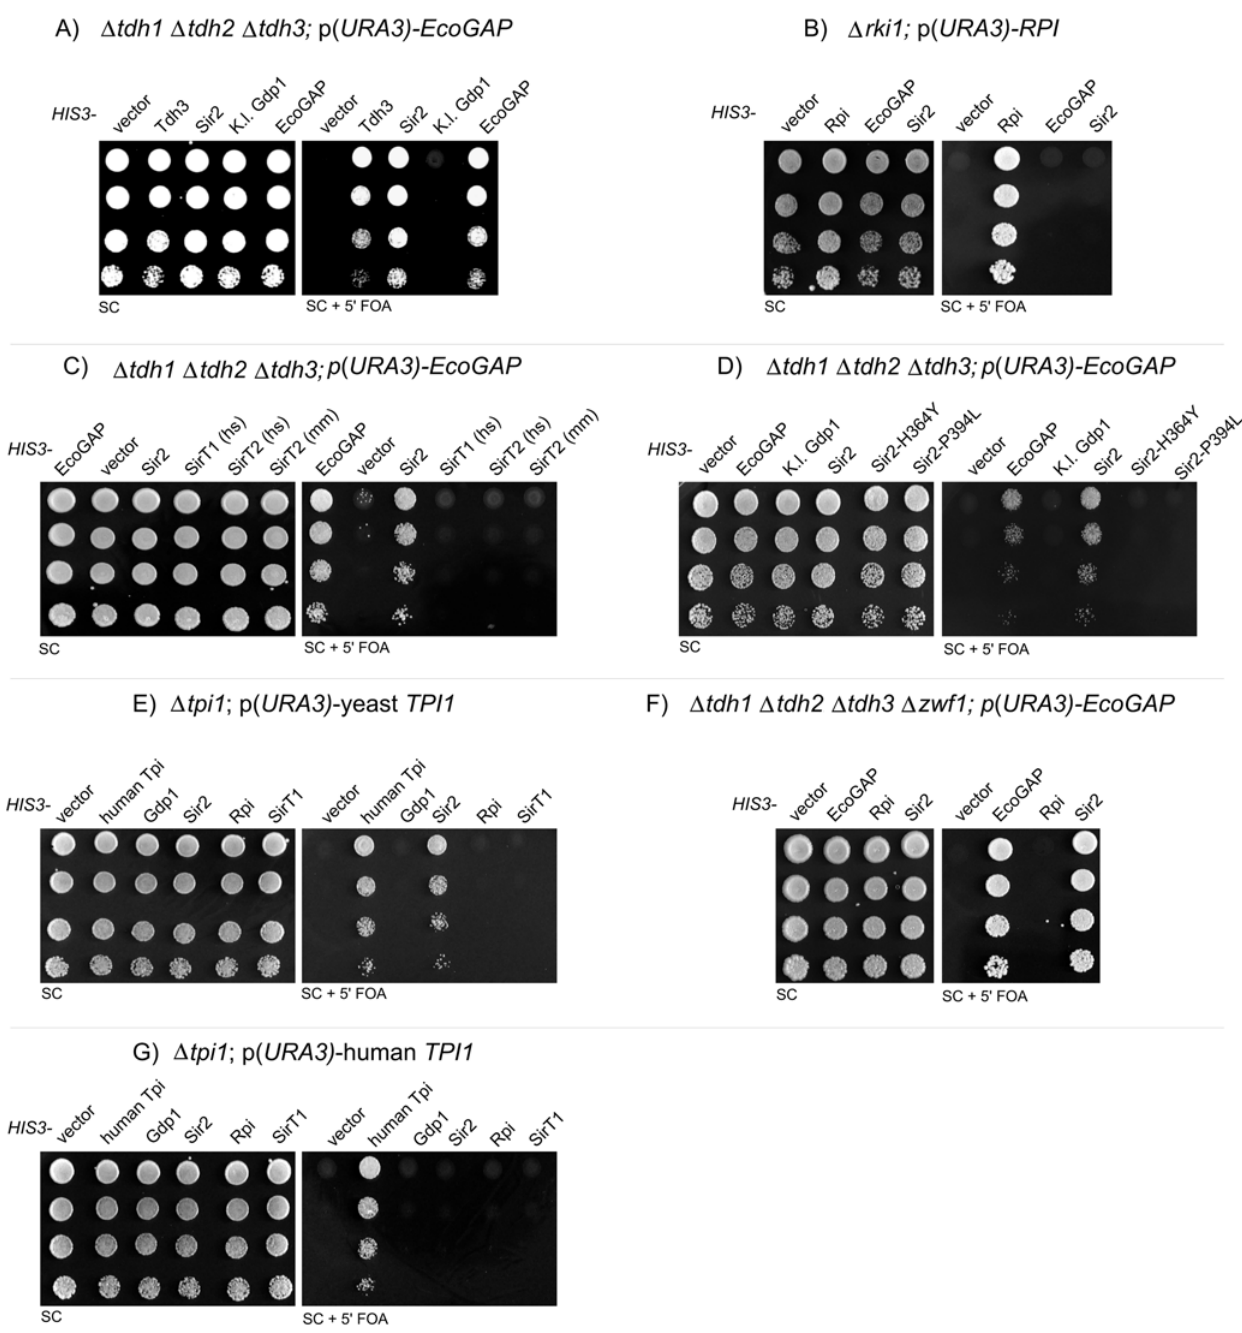
Figure 1. D tdh1 D tdh2 D tdh3 yeast survives counter-selection of a GAPDH-encoding plasmid when Sir2 is overexpressed. (A) The D tdh1 D tdh2 D tdh3 strain MR173 containing the plasmid p( URA3 )- Eco GAP was transformed with the indicated HIS3 plasmids. Transformants were selected, grown overnight, and spotted in a five-fold serial dilution on SC media containing 5 9 FOA for counter-selection of the URA3 plasmid or on SC media as control. Plates were then incubated for 3 days at 30 u C. (B) Similar experiment as described in (A), but using D rki1 yeast expressing the human RKI1 orthologue (Rpi1) from the URA3 plasmid. (C) D tdh1 D tdh2 D tdh3 yeast overexpressing Sir2 or its mammalian homologues, human SirT1, human SirT2, and mouse SirT2, were processed as in (A). (D) Similar to (C), but overexpressing the mutant proteins Sir2 H364Y and Sir2 P394L . (E) The yeast strain MR110, in which chromosomal TPI1 is deleted and yeast TPI1 is expressed from an URA3 episome, was transformed with the indicated HIS3 plasmids and processed as described above. (F) Similar experiment using the quadruple deletion strain D tdh1 D tdh2 D tdh3 D zwf1 . (G) Similar to (E), but using yeast strain MR101, which is isogenic to MR110, but expresses human instead of yeast Tpi1 from the URA3 episome.